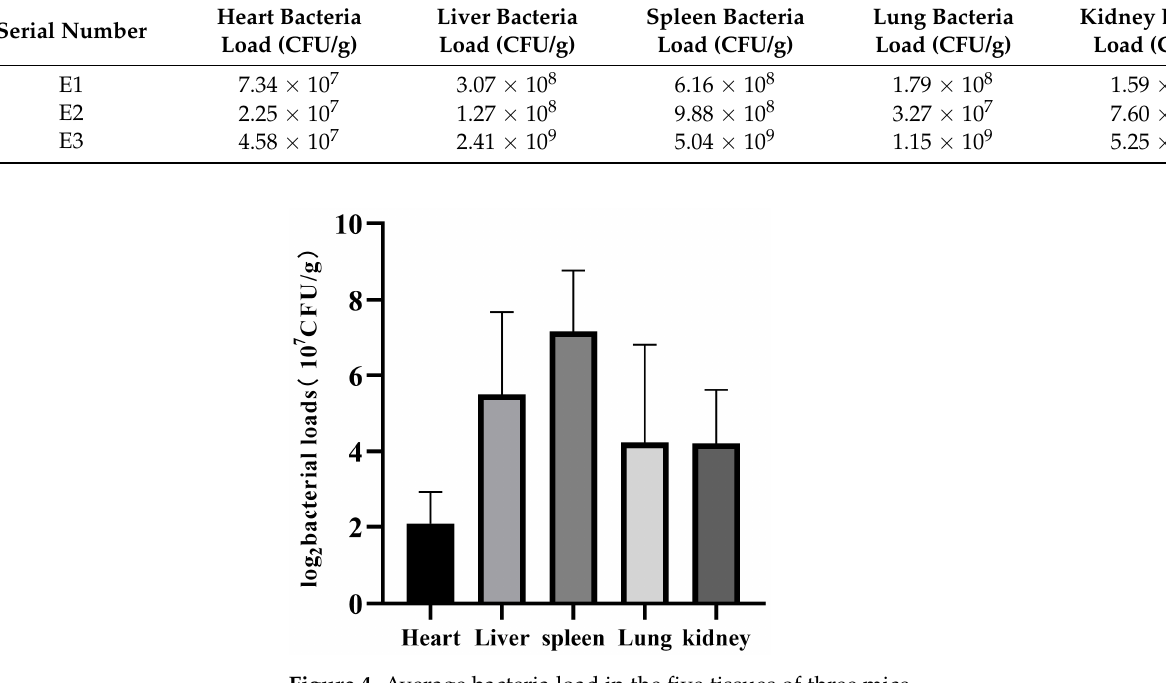
Table 4. Bacterial load in the five tissues of three mice.